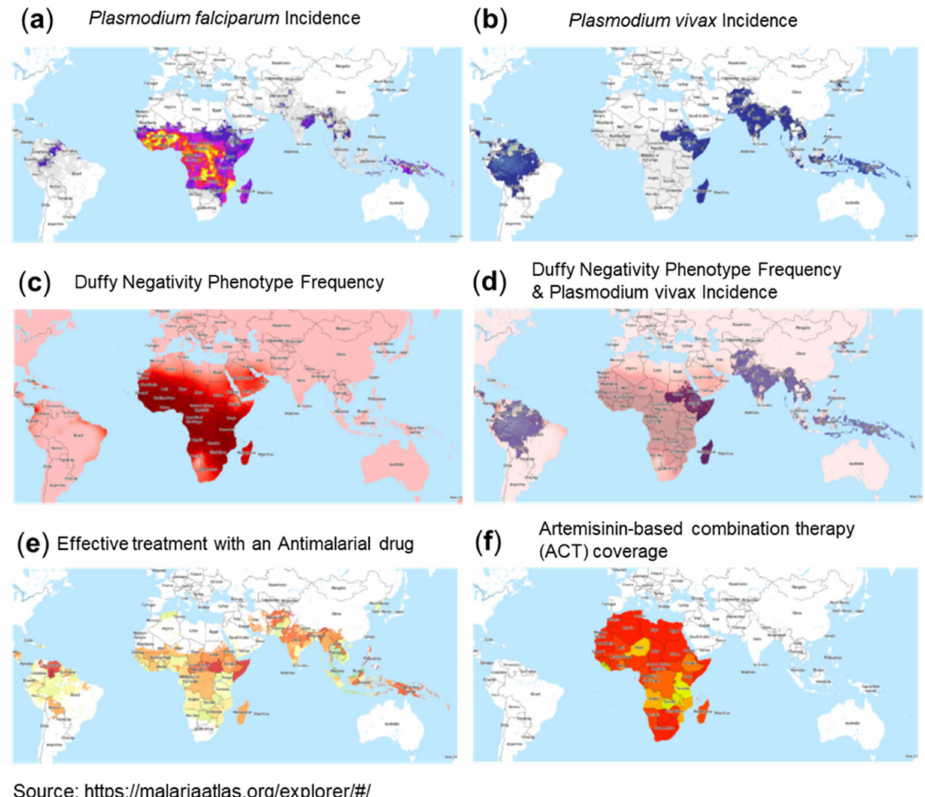
Figure 4. Plasmodium falciparum incidence ( a ), Plasmodium vivax incidence ( b ), Duffy negativity phenotype frequency ( c ), Duffy negativity phenotype frequency and Plasmodium vivax incidence overlay ( d ), Effective treatment with an antimalarial drug ( e ), and Artemisinin-based combination therapy (ACT) coverage ( f ). Source: Malaria Atlas Project, https://malariaatlas. org/explorer/#/ accessed on 5 July 2021. Note: high incidence regions of the two major plasmodium species, Plasmodium falciparum and Plasmodium vivax , partially overlap; however, they show large discrepancies in sub-Saharan Africa despite similar climatic needs. This may be considered a consequence of the high level of Duffy negativity in the sub-Saharan African population, which serves as the entry receptor for Plasmodium vivax into erythrocytes, whereas Plasmodium falciparum uses multiple entry receptors. Among the countries with effective treatment with anti-malaria drugs, only Africa has high ACT